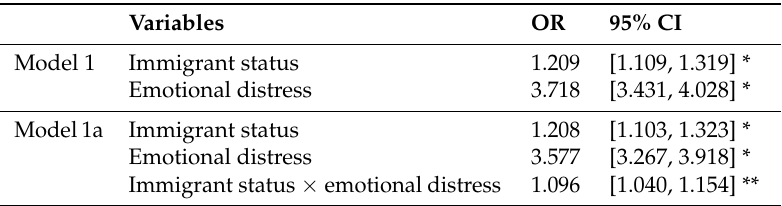
Table 3. Ordinal logistic regression models: associations between immigration status, emotional distress, and insomnia symptoms (total population).